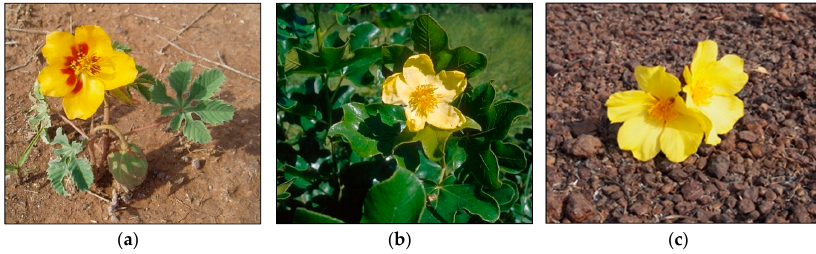
Figure 2. Examples of Cochlospermaceae: ( a ) herbaceous Amoreuxia wrightii flowering and fruiting in Nuevo Leon, Mexico; ( b ) Cochlospermum planchonii (sub-shrub) exhibiting characteristic large yellow flowers and palmately lobed leaves in Senegal, West Africa; ( c ) Cochlospermum tinctorium (sub-shrub) blooming straight from the ground after a savannah fire in Senegal, West Africa.